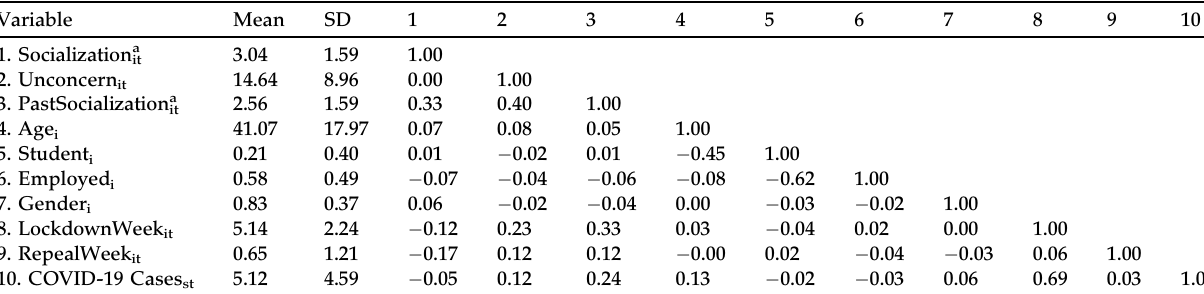
Table 4. Descriptive statistics and correlation matrix.